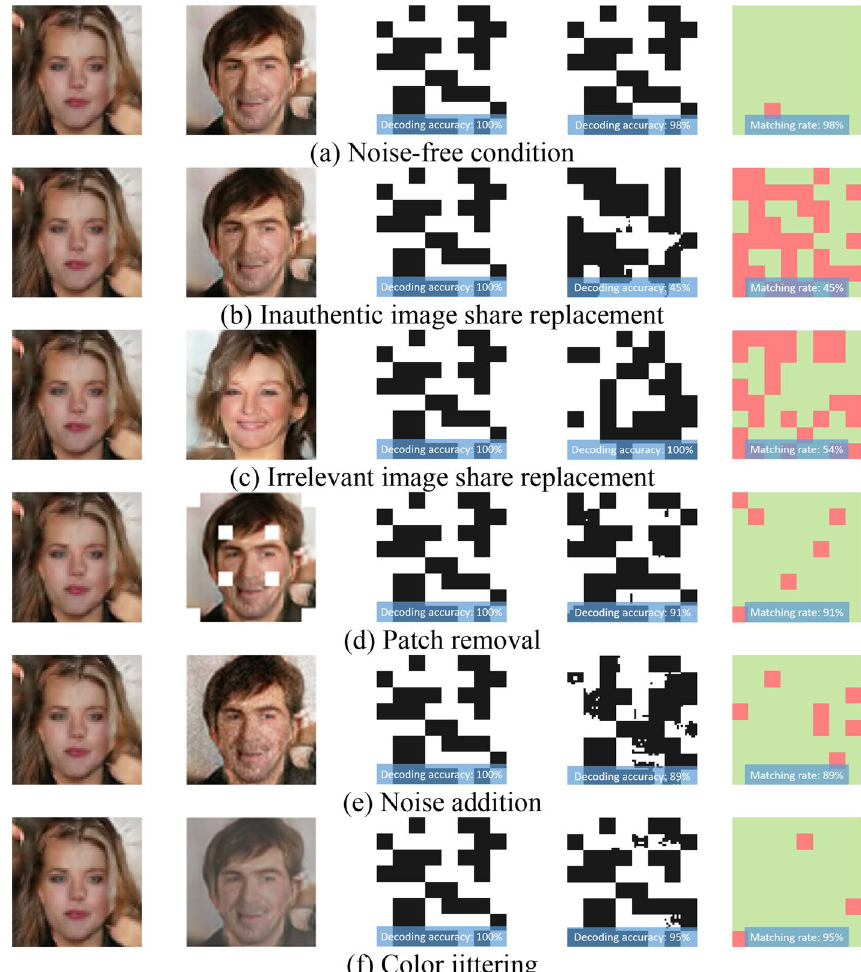
Fig. 8 Examples of sensitivity and robustness against cheater and